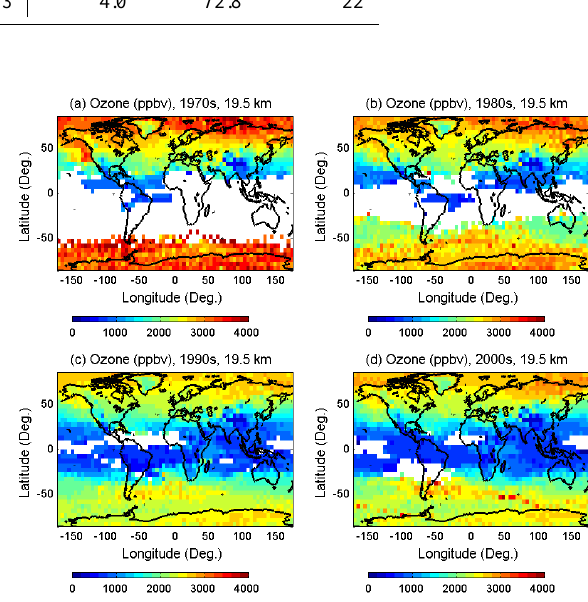
Fig. 12. Decadal variation in ozone at 19.5 km for (a) the1970s, (b) the 1980s, (c) the 1990s, and (d) the 2000s. White areas indicate missing data.